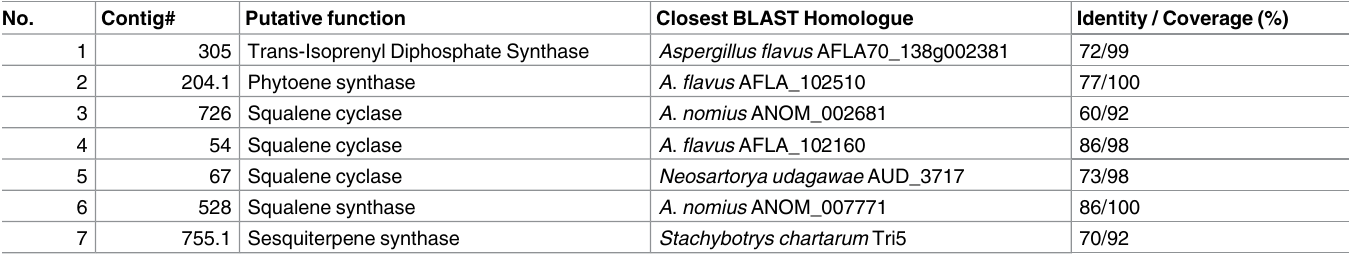
is homologous to the cyclopiazonic acid biosynthetic gene cluster (BGC0000977_c1). Spera- dine F is a highly oxygenated and N -methylated analogue of cyclopiazonic acid and thus is likely to be encoded by the above PKS-NRPS gene cluster in A . hancockii . The A . hancockii Table 6. Genes involving in terpene biosynthesis in the A . hancockii genome.